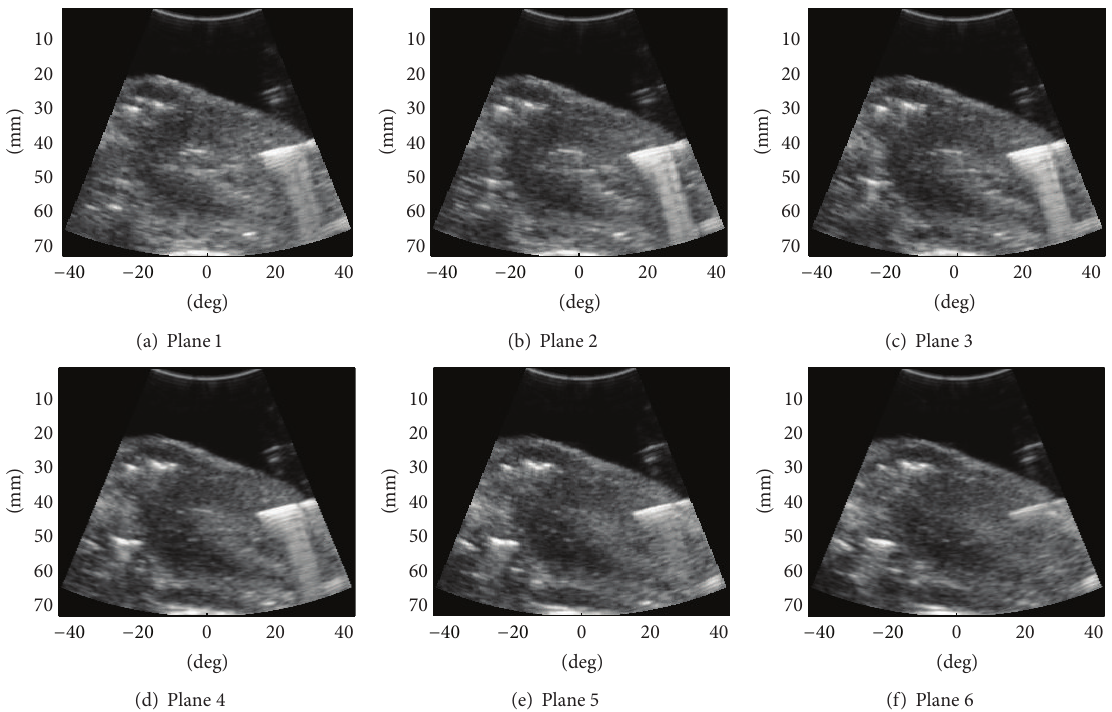
Figure 6: The detected tool plane and its neighbor